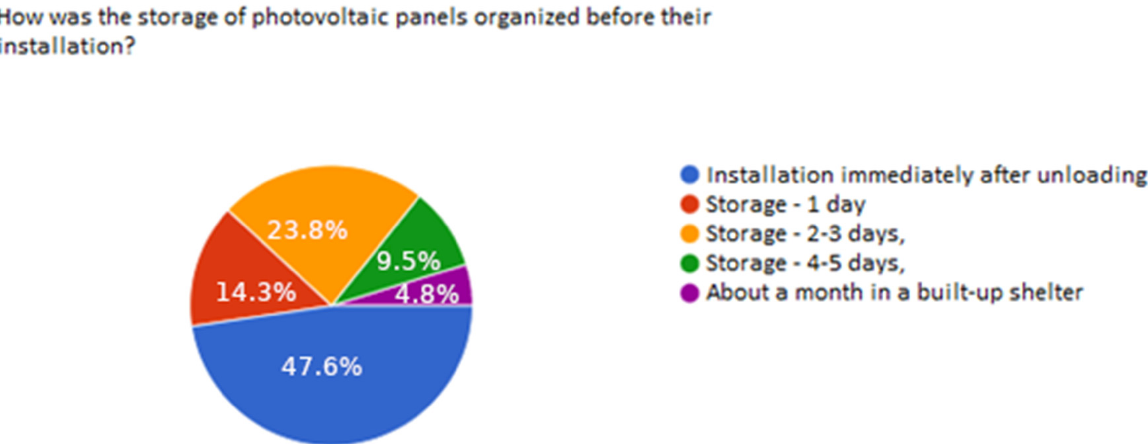
Figure 13. Duration of panel assembly.